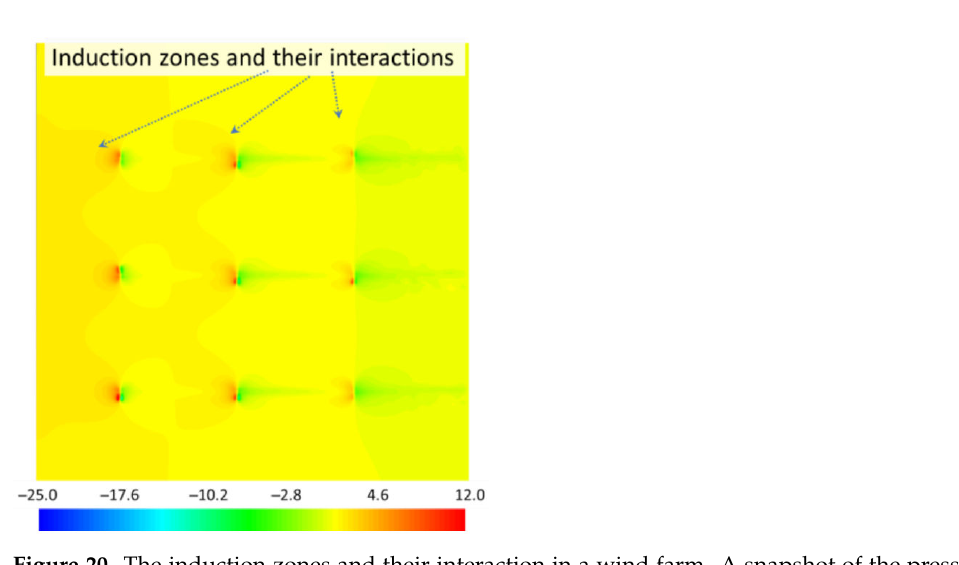
Figure 20. The induction zones and their interaction in a wind farm. A snapshot of the pressure distribution of the wind farm layout in the plane that passes through the turbine centers.